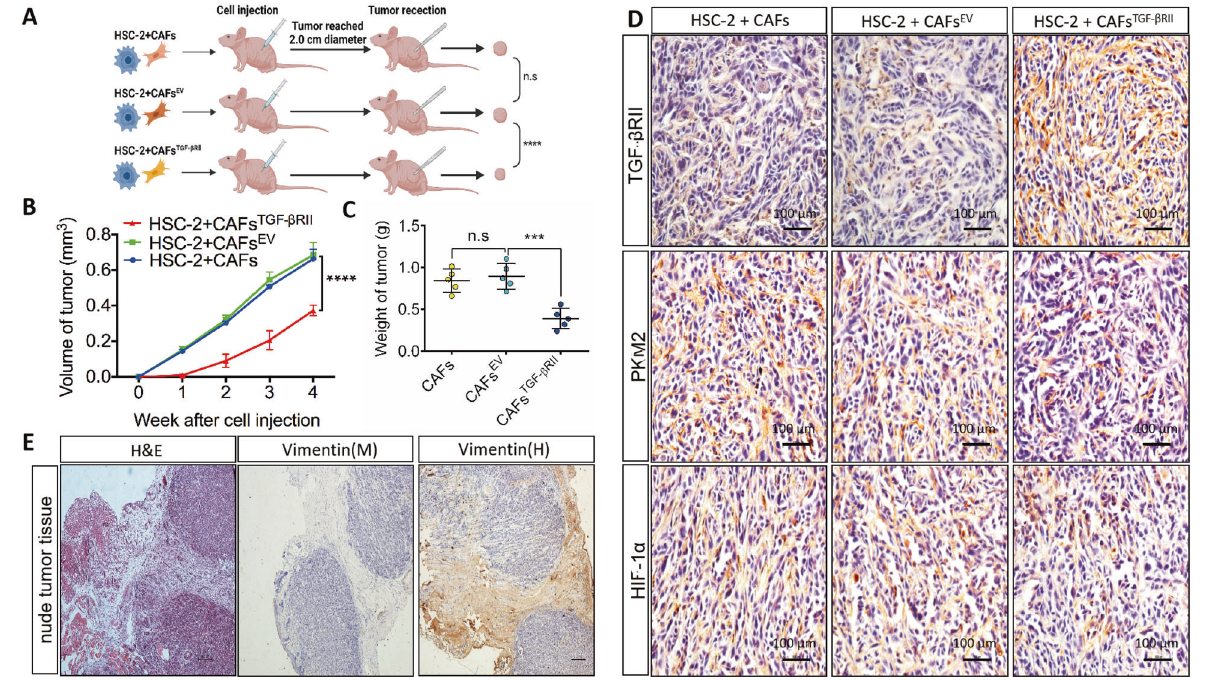
Fig. 3 Overexpressed TGF- β RII suppressed tumor growth. A Schematic diagram of xenograft mouse models in vivo. B , C HSC-2 tumors were measured with calipers, and volume was calculated every week; the difference between controls and experimental groups of tumor volume and weight were found at the fi nal time point. D Representative immunohistochemistry staining of TGF- β RII, PKM2, and HIF-1 α in tumors of HSC-2-bearing nude mice. E Veri fi cation of the source of transplanted tumor cells. The staining of anti-mouse vimentin was negative while anti-human vimentin was positive. n ≥ 3; error bars, mean ± SD; n.s. not signi fi cant, ** P < 0.01, *** P < 0.001, **** P < 0.0001; t